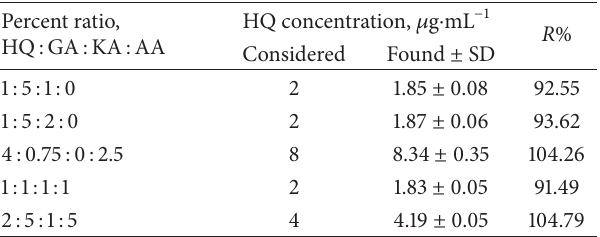
Table 5: Results of the HQ determination in ternary and quaternary synthetic mixtures by applying the proposed spectrometric method; 𝑛 = 3